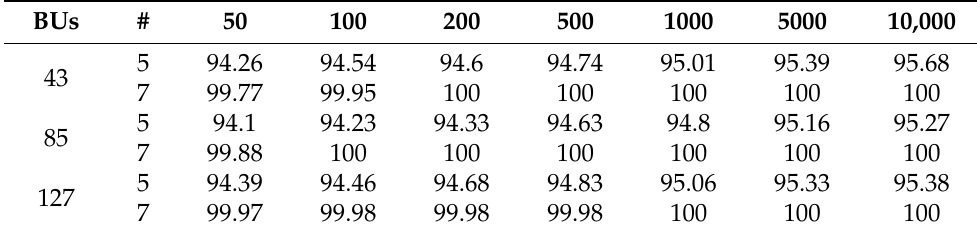
Table 1. Average of late deliveries on the worst day by the number of solutions generated during the first phase of the algorithm, Columns ‘50’, ‘100’, ‘200’, ‘500’, ‘1000’, ‘5000’, and ‘10,000’ and instance parameters (number of basic units in column ‘BU’, and number of generated districts in column ‘#’) for instances with low demand.